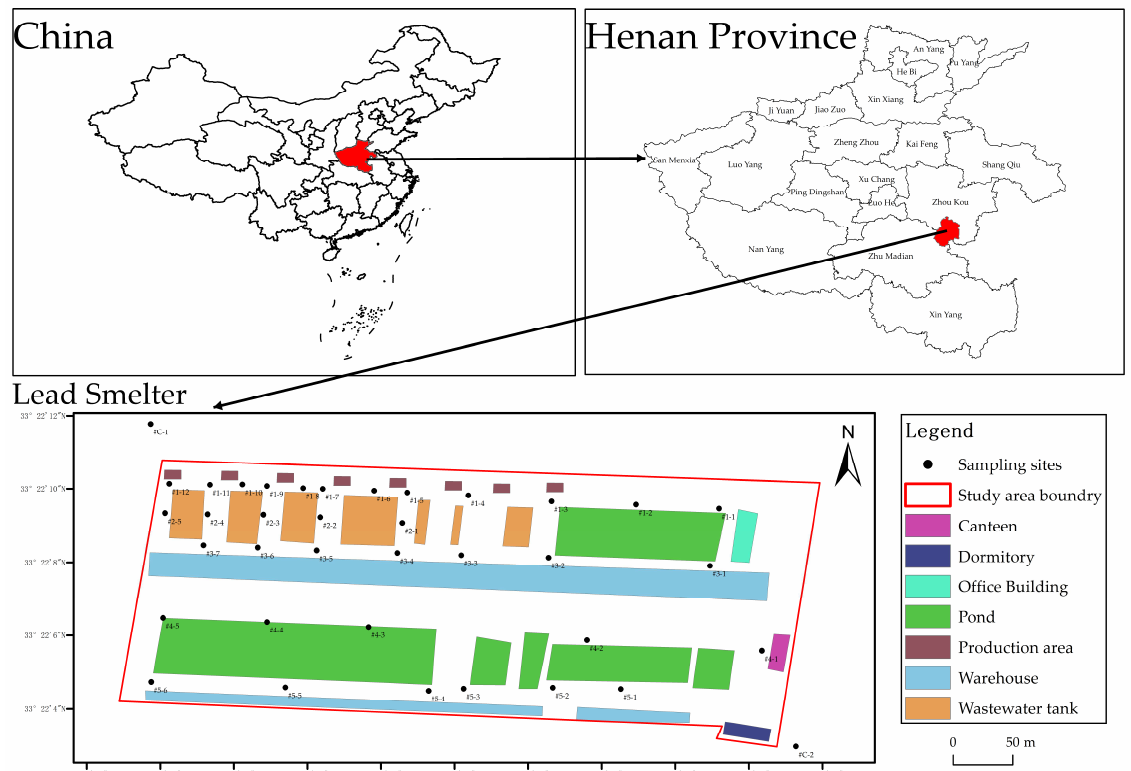
Figure 1. Location of sampling sites in the study area.